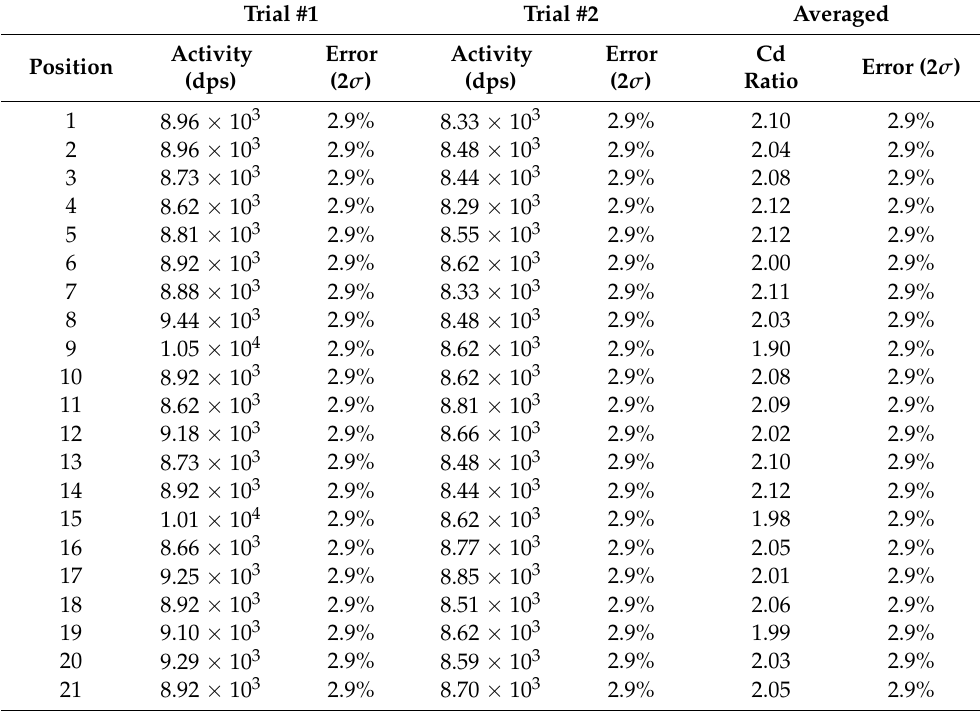
Table 6. Cadmium covered gold foil activity measurements (ERS).